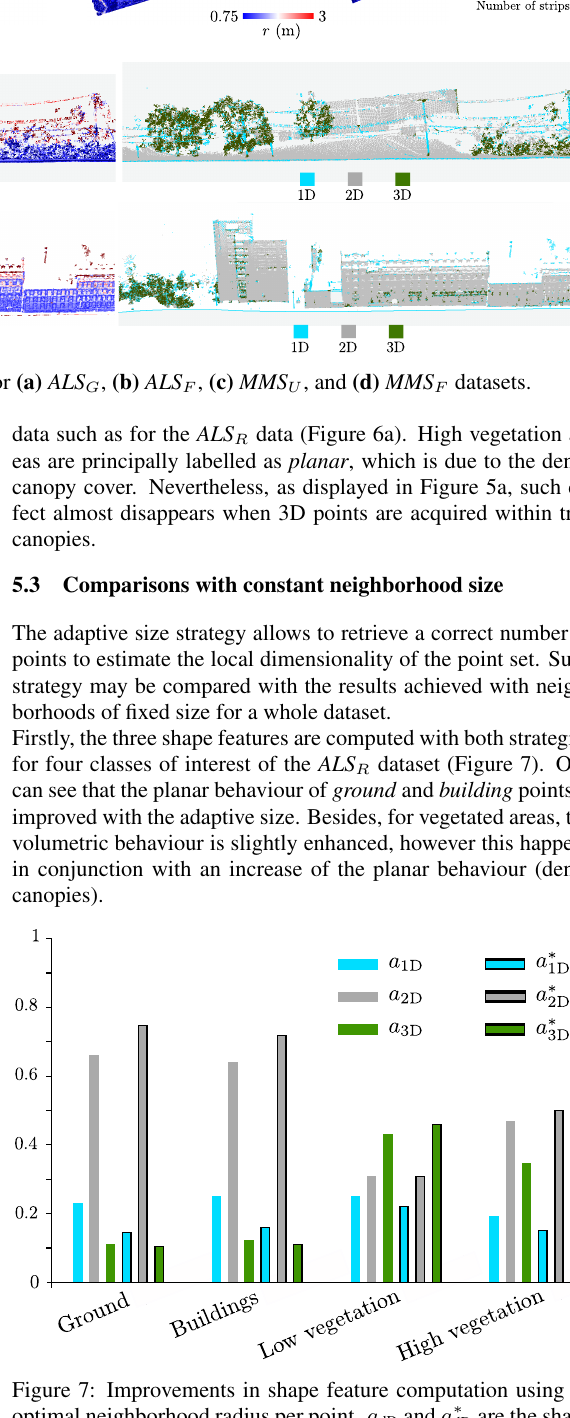
are the shape dD